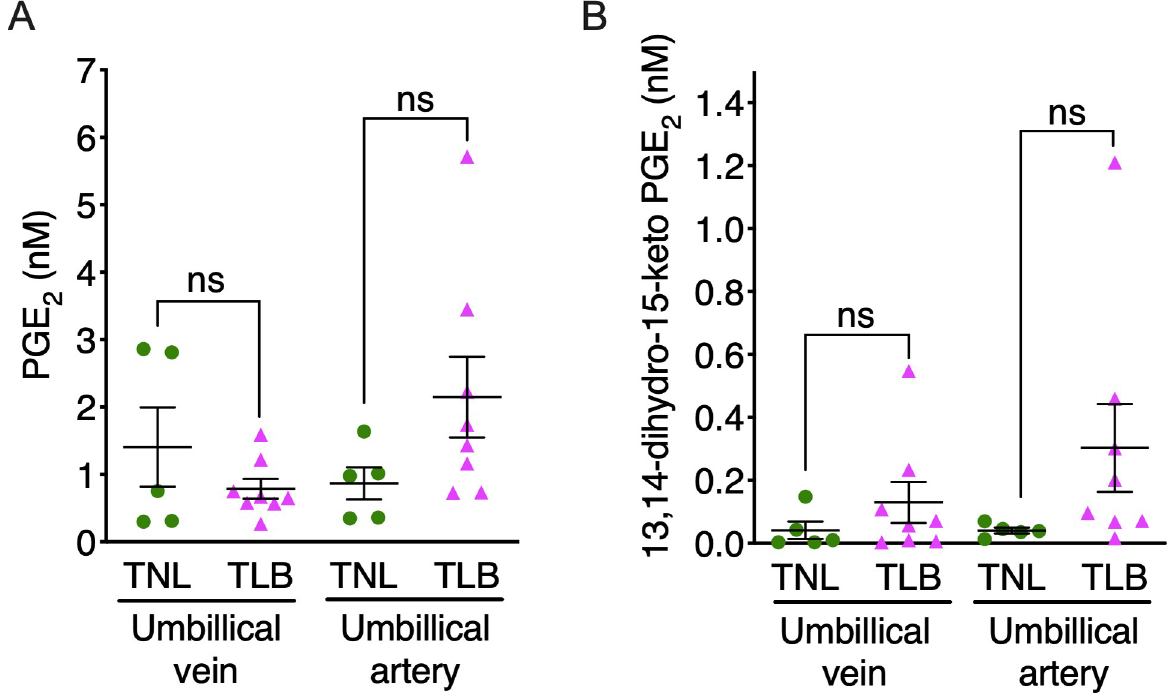
Fig 2. Levels of prostaglandin E 2 (PGE 2 ) and its metabolites in umbilical cord blood. Levels of PGE 2 and its metabolites in umbilical cord blood from patients with term not in labor (TNL) and term in labor (TLB) deliveries were quantified by LC-MS/MS. (A) PGE 2 and (B) 13,14-dihydro- 15-keto-PGE 2 in blood from umbilical cord veins and arteries of patients with term not in labor (TNL) and term in labor (TLB) deliveries were quantified by LC-MS/MS. TNL, n = 6; TLB, n = 8. Horizontal lines and error bars indicate the mean ± SEM. Data were analyzed by unpaired Student’s t tests with Welch’s correction. ‘ns’, not